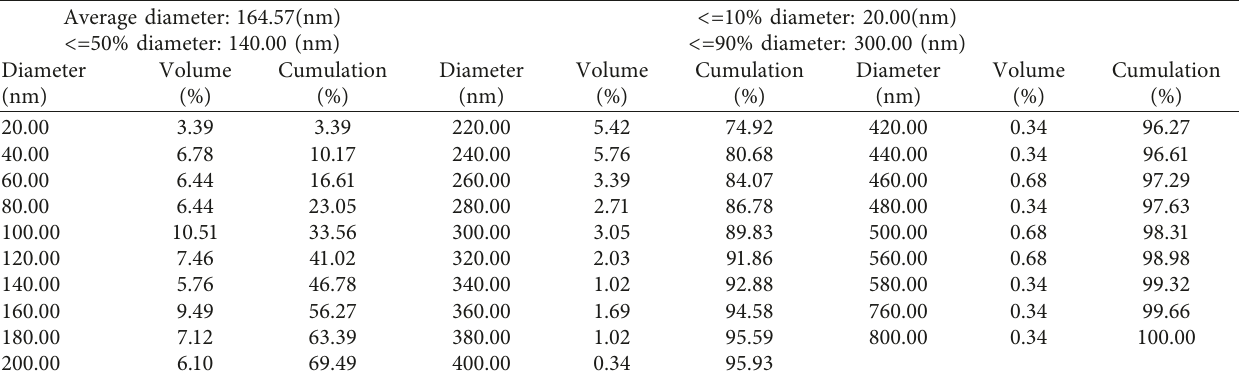
Table 1: Granulation distribution